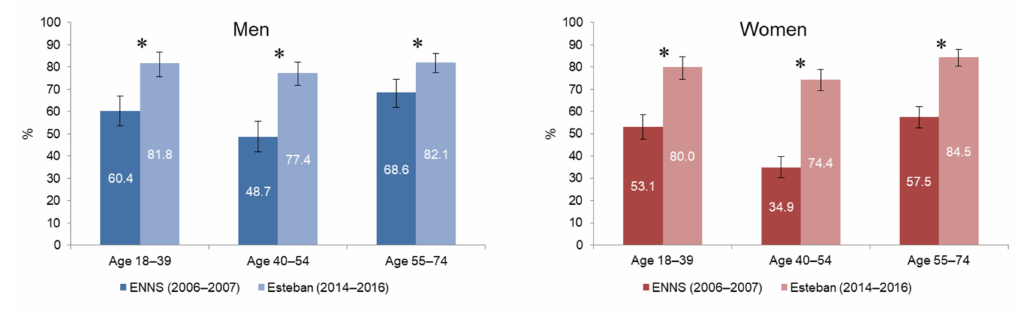
Figure 3. Prevalence of men and women aged 18–74 years reporting 3 or more hours of daily leisure screen time 1 , between ENNS (2006–2007) and Esteban (2014–2016). 1 Leisure screen time includes TV, computer and game console time outside of any professional activity. * significant change ( p <